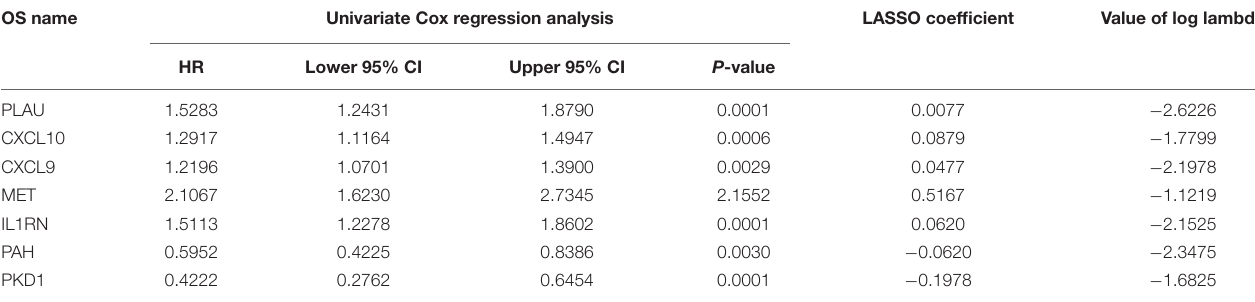
FIGURE 6 | Construction of prognostic model in the TCGA and validation cohorts. (A) Univariate Cox regression analysis for identifying prognosis-related OS genes in TCGA cohort. (B,C) LASSO analysis for determining the number of factors and constructing the prognosis prediction model. (D) Risk score distribution, survival status, and expression heat map of TCGA cohort. (E) Risk score distribution, survival status, and expression heat map of validation cohort. TABLE 2 | Seven prognosis-associated OS genes with PC in the TCGA dataset were identified by LASSO